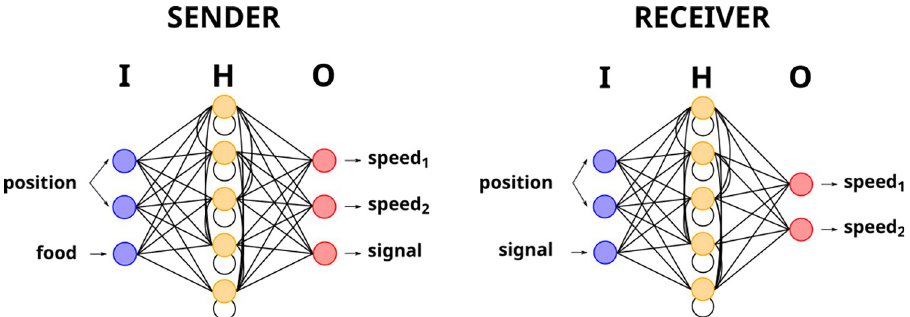
Fig 8. Illustration of agent neural controllers. The agents’ controllers were comprised of two continuous-time, recurrent neural networks (CTRNN) with a fully connected hidden layer of five neurons. The input and output units of the agents differed to match the specific sensory and communication apparatus of signalers and receivers. Connections between neurons are represented by black lines and input, hidden and output layers are respectively designated as I , H and O